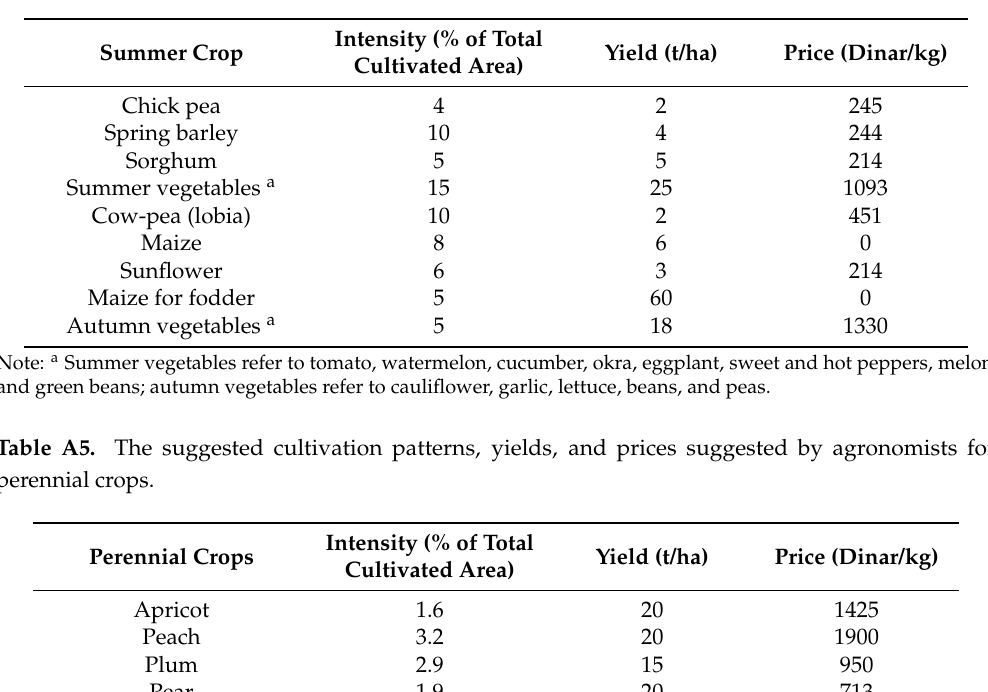
Table A4. The suggested cultivation patterns, yields, and prices for summer crops.